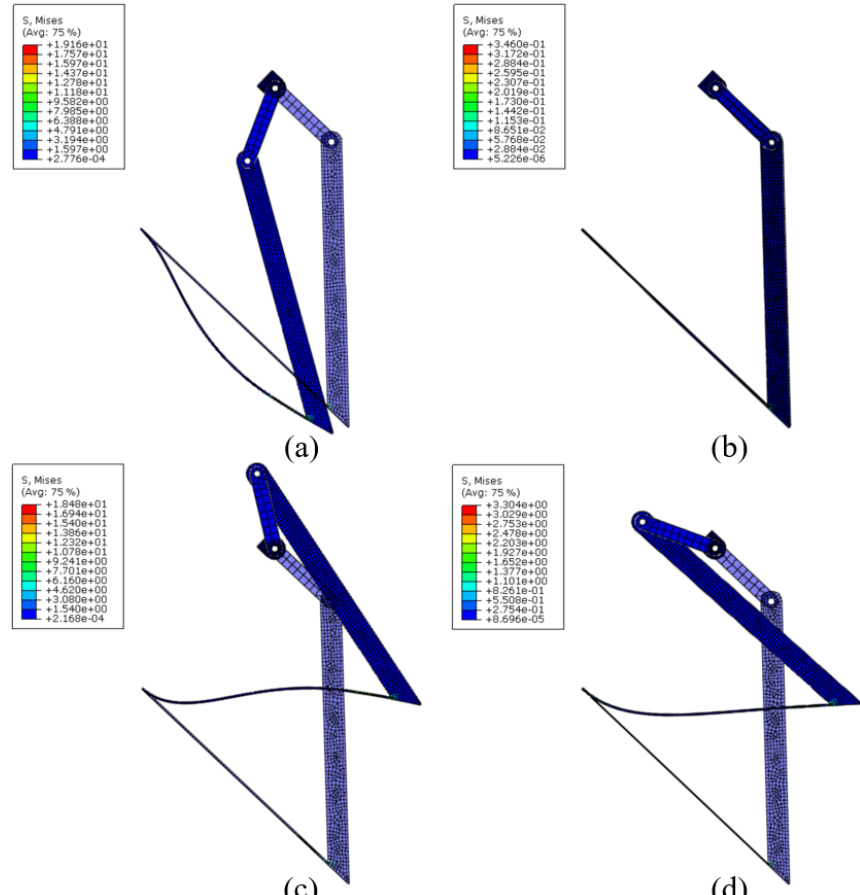
Figure 18. Deformation of the flexure beam. (a) E 1 . (b) E 2 . (c) E 3 . (d) E 4 .